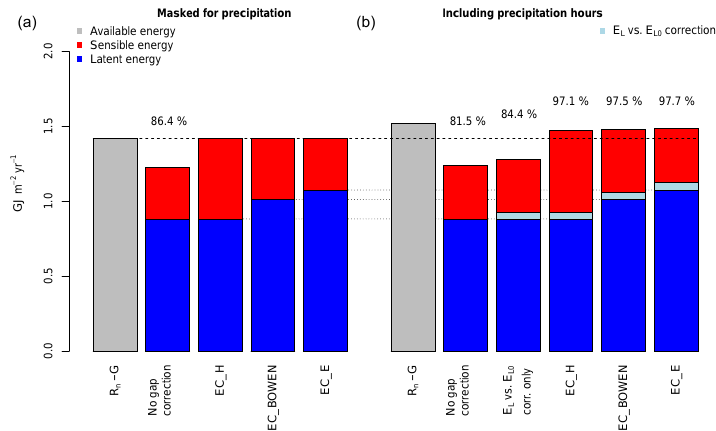
Figure 8. Yearly aggregated available energy ( R n − G ) vs. sum of turbulent fluxes (for daytime, time period June 2009 to December 2015, excluding gap-filled data), with percentages denoting the amount of closure. (a) Totals calculated from hourly data masked for precipitation. The energy closure amounts to 86.4% for the measured turbulent fluxes (i.e., no gap correction) and the gap becomes per-definition closed for the three applied corrections (i.e., correction according to the Bowen ratio EC_BOWEN, and correction by assigning the energy balance closure gap to sensible heat-flux only EC_H and to latent heat-flux only EC_E; see Sect. 2.3). (b) Totals calculated by including also precipitation hours. Here the gap is corrected by applying a correction for missed evapotranspiration during hours with precipitation (based on the lysimeter evapotranspiration estimates E L and E L ; denoted E L vs. E L correction) plus considering the energy gap correction based 0 0 on the precipitation-masked data (see text for